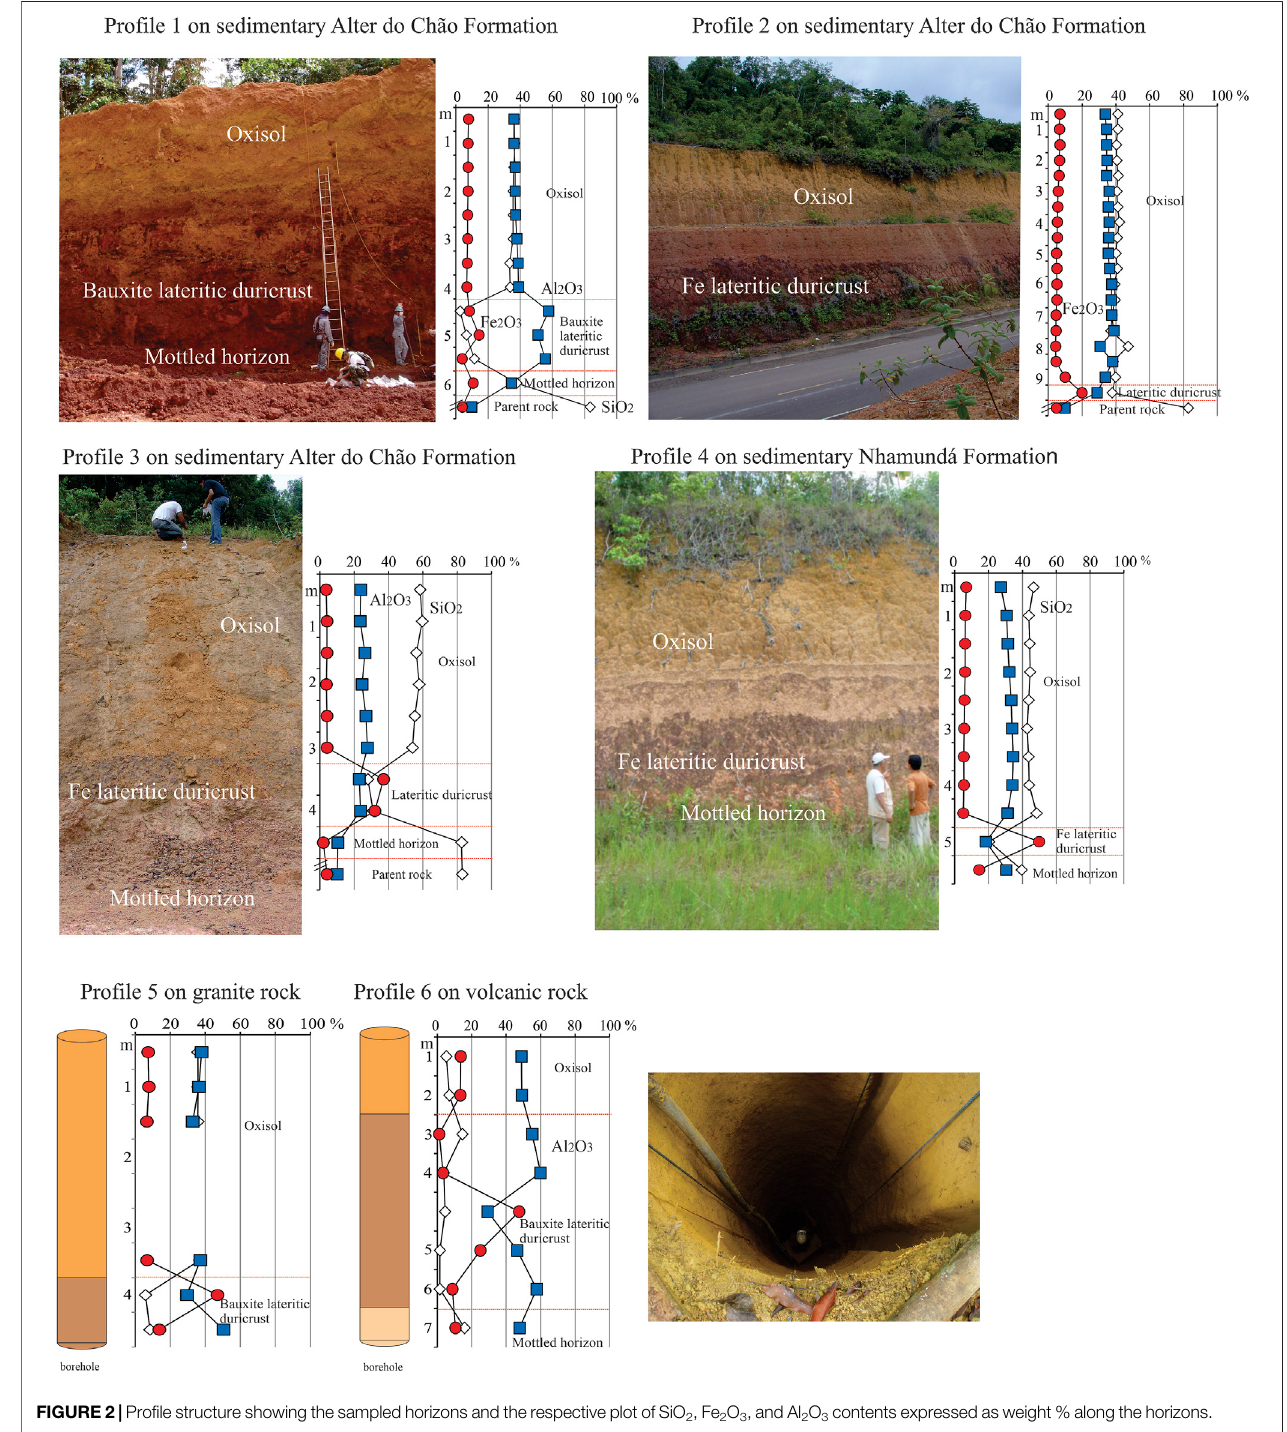
Frontiers in Earth Science |